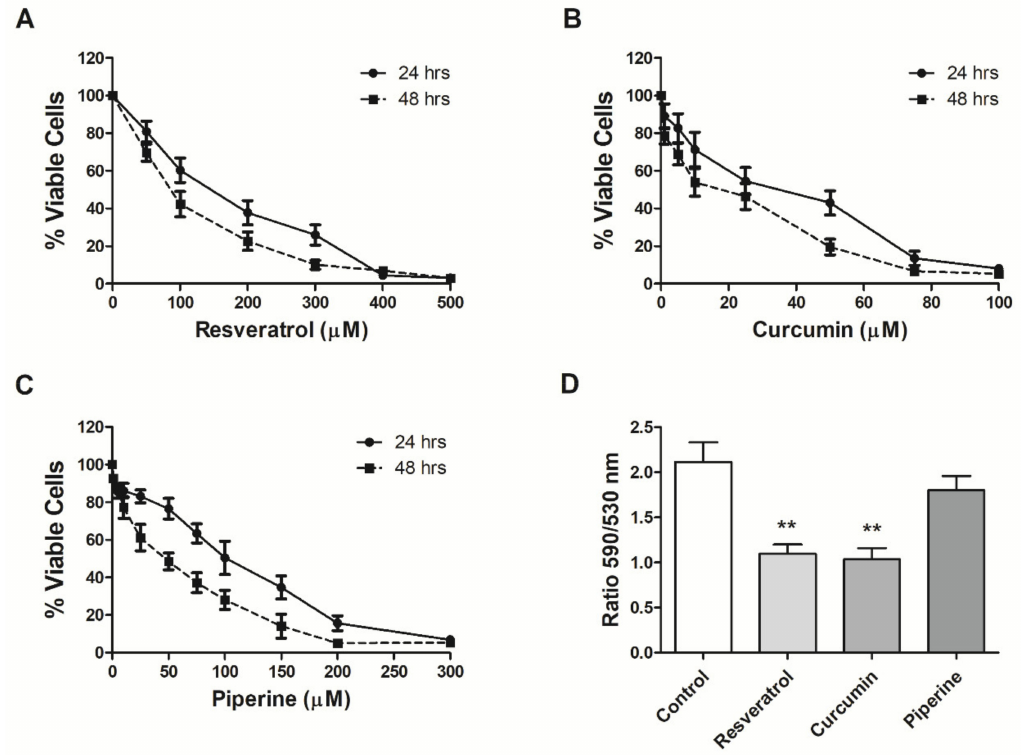
Figure 2. Resveratrol, curcumin and piperine MCF-7 cell viability and mitochondrial membrane potential: Cells were treated for 24 ( • ) and 48 ( (cid:4) ) h with di ff erent resveratrol ( A ), curcumin ( B ) or piperine ( C ) concentrations, and cell viability was then determined by the 3-(4,5-dimethylthiazol- 2-yl)-2,5-diphenyltetrazolium bromide (MTT) assay. ( D ) Cells were treated for 24 h with 131.0 µ M resveratrol, 24.5 µ M curcumin or 94.5 µ M piperine, and mitochondrial membrane potential was determined by 5,5 (cid:48) ,6,6 (cid:48) -tetrachloro 1,1 (cid:48) ,3,3 (cid:48) -tetraethyl benzimidazolyl carbocyanine iodide (JC-1) staining. The results are representative of three experiments performed in triplicate ± SEM. ** p < 0.001 in relation to the